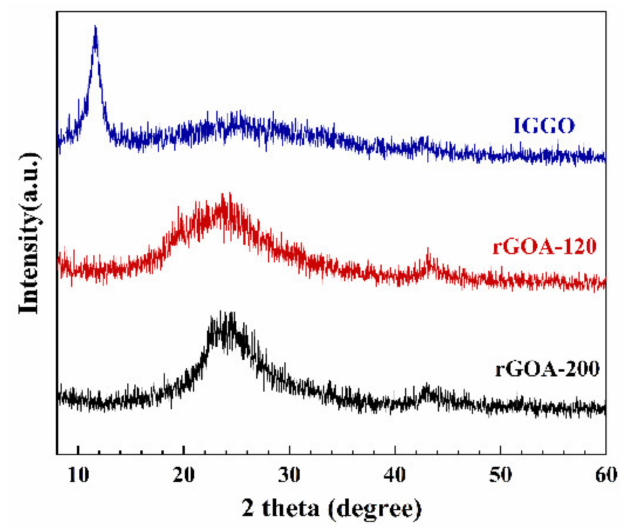
Figure 4. XRD patterns of the